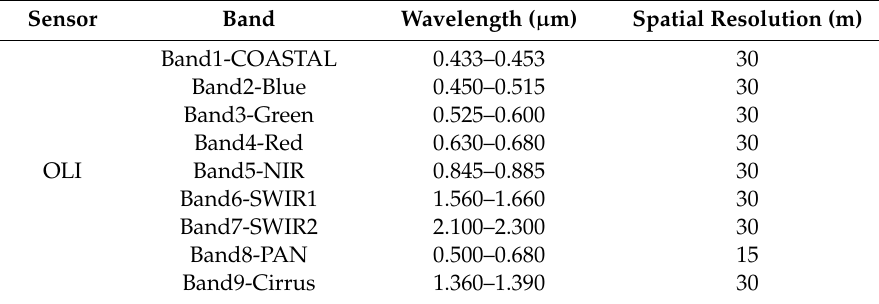
Table 1. Information about Landsat8.